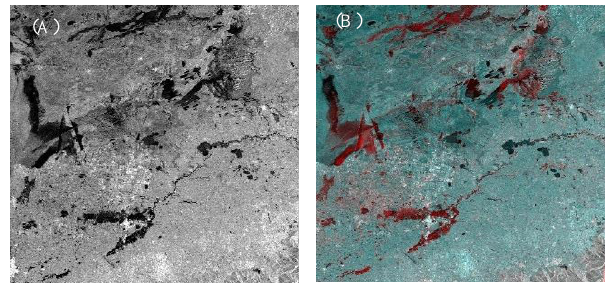
Figure 3. (A) HSV Image Cluster, (B) RGB Image Cluster